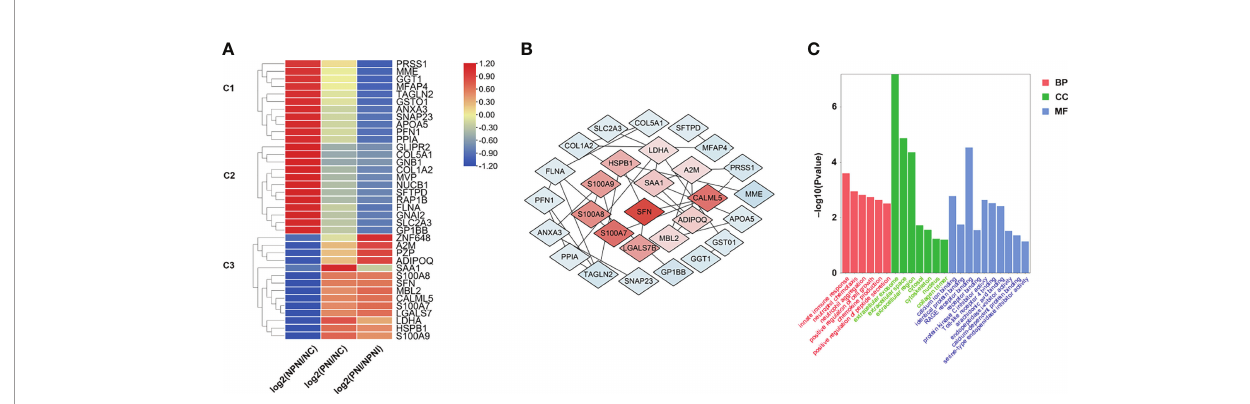
FIGURE 4 | Hierarchical clustering analysis and heatmap of DEPs. (A) The heatmap was constructed based on a log2 transformation of relative abundance ratios (NPNI/PNI). (B) Protein-protein interaction (PPI) network analysis of differentially expressed proteins (DEPs) between the NPNI and PNI groups. (C) Gene ontology annotation of upregulated proteins enriched in Cluster 3 based on biological process, cellular component, and molecular function.